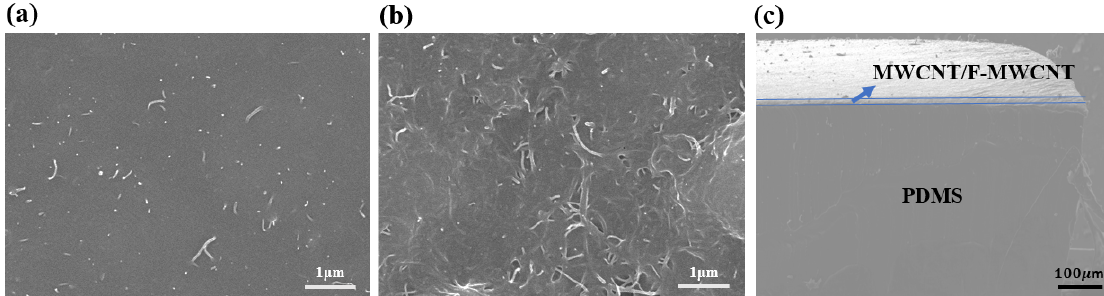
Figure 3. SEM image of the surface of MWCNT before ( a ) and after ( b ) the dip coating process with F-MWCNT solution. ( c ) Cross section of the F-MWCNT/MWCNT/PDMS